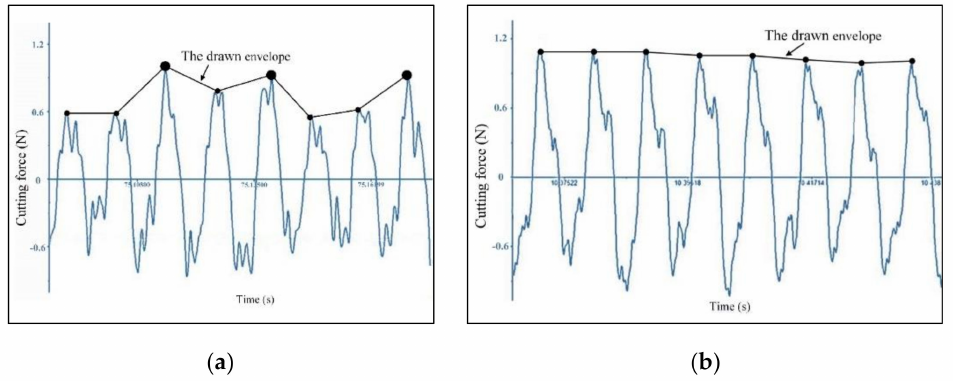
Figure 7. The comparison of cutting force signal waveform at di ff erent feed per tooth ( a p = 5 µ m, n = 16,000 rpm): ( a ) f z = 0.22 µ m, ( b ) f z = 2.2 µ m.